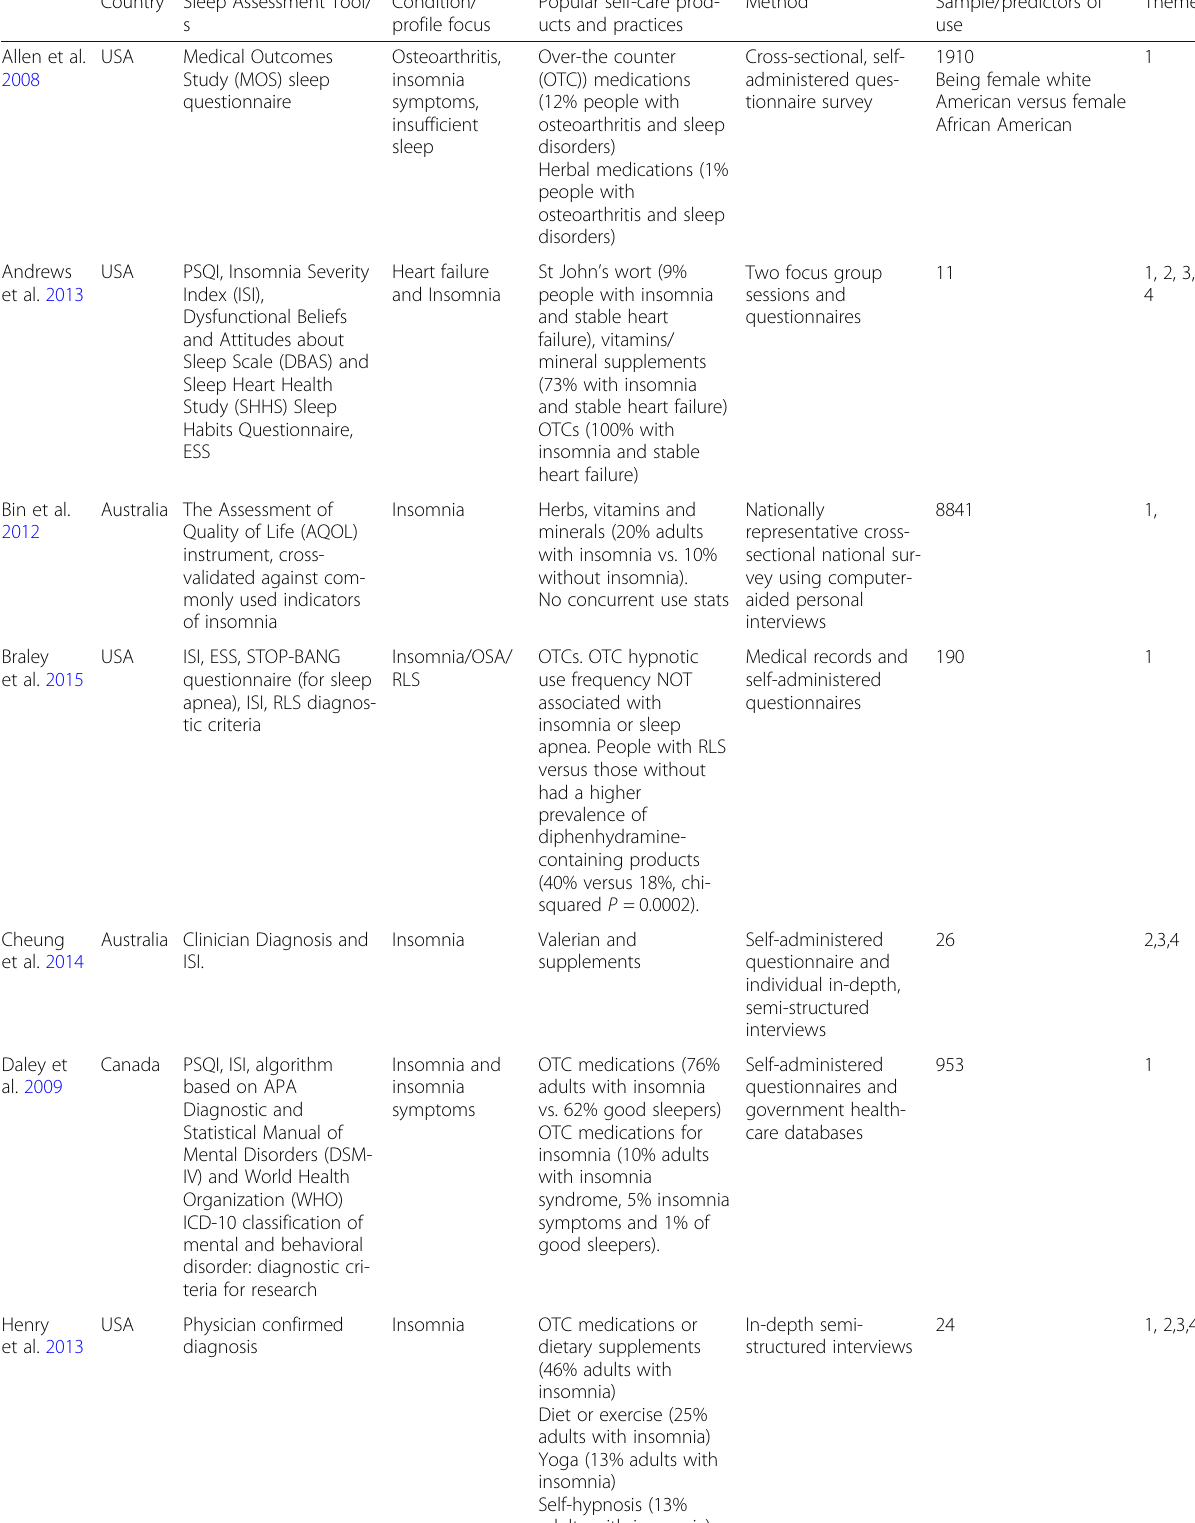
Table 1 Research-based studies of self-care for adults for sleep disturbances, 2006 – 2016 Country Sleep Assessment Tool/